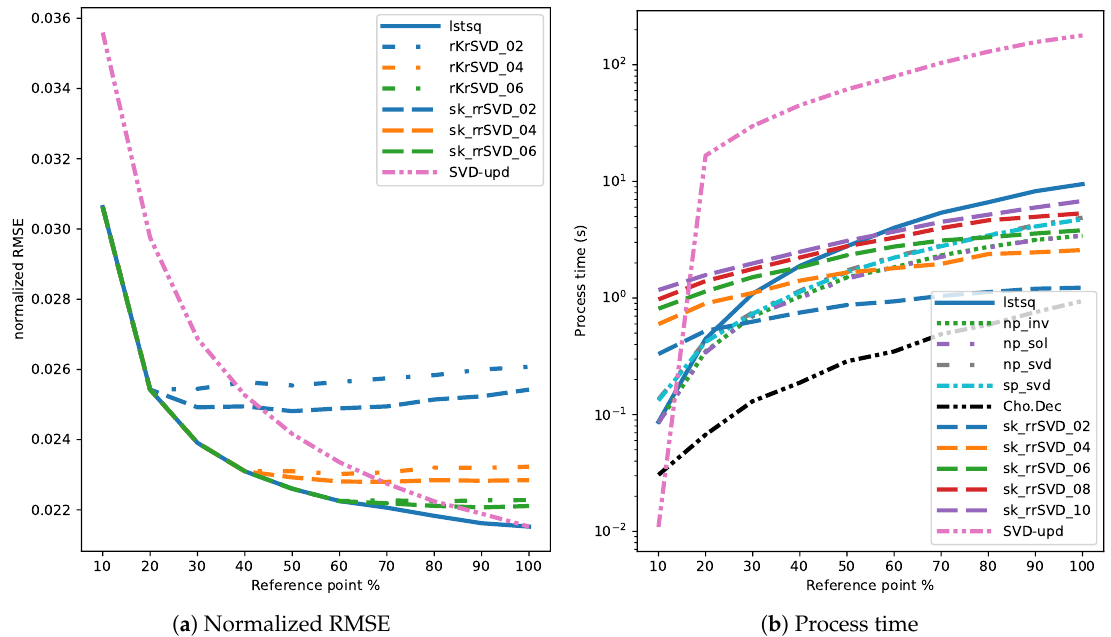
Figure 2. Normalized RMSE values ( a ) and process times ( b ) as a function of reference points for the Airplane Companies Stocks dataset. In ( a ), only methods that at any reference point percentage differ from Lstsq with Kruskal–Wallis H test are shown along Lstsq .